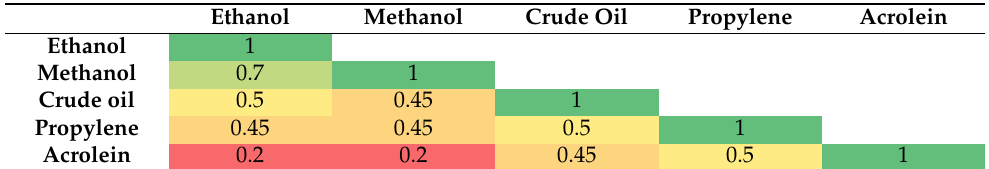
Table 4. Proposed correlation matrix for the future, based on historical data and expert